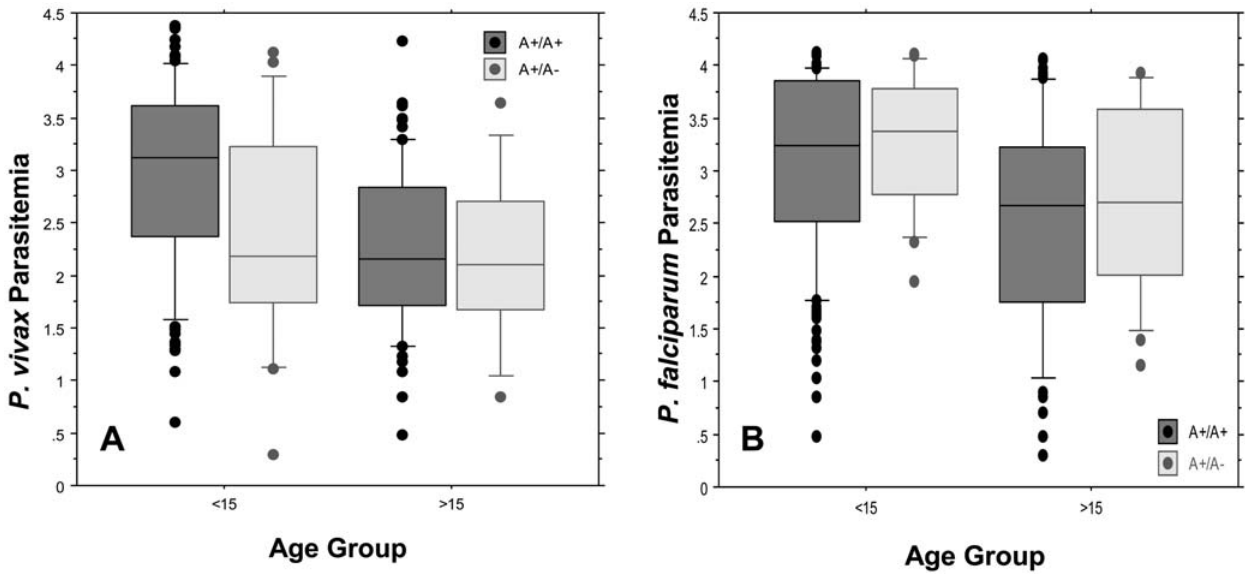
Figure 3. Semi-quantitative LDR-FMA Diagnosis of Pv and Pf infections split by Duffy Genotype and Age Group. A, Comparison of Pv fluorescent signal intensity (log 10 -transformed) of individuals who had a Pv-positive blood sample split by Duffy genotype (matched on age, sex, village of residence, and survey period). For children less than 15 years of age, A + /A + (n=105) mean fluorescent signal intensity=2.96, A + /A 2 (n=18) mean fluorescent signal intensity=2.37 (Mann-Whitney P =0.023). For individuals over 15 years, A + /A + (n=66) mean fluorescent signal intensity=2.22, A + / A 2 (n=15) mean fluorescent signal intensity=2.16 (Mann-Whitney P =0.86). B, Comparison of Pf fluorescent signal intensity (log 10 -transformed) of individuals who had a Pf-positive blood sample split by Duffy genotype (matched on age, sex, village of residence, and survey period). For children less than 15 years of age, A + /A + (n=146) mean fluorescent signal intensity=3.08, A + /A 2 (n=17) mean fluorescent signal intensity=3.22 (Mann- Whitney P =0.742). For individuals over 15 years, A + /A + (n=89) mean fluorescent signal intensity=2.51, A + /A 2 (n=22) mean fluorescent signal intensity=2.69 (Mann-Whitney P =0.529).